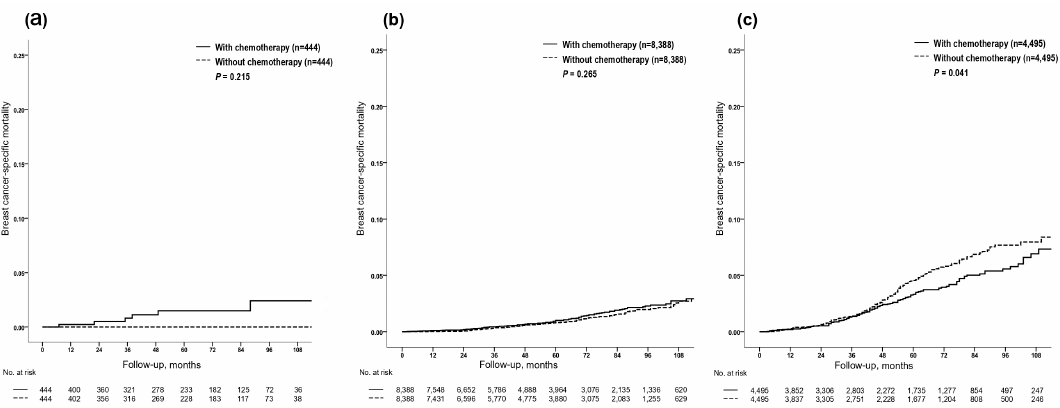
Figure 1. The Kaplan–Meier estimates of the risk of BC death according to chemotherapy by RS risk groups ( < 11, 11–25, > 25) in the matched cohort. ( a ) low-risk, RS < 11; ( b ) intermediate-risk, RS 11–25; ( c ) high risk, RS > 25. Abbreviations: BC, breast cancer; RS, recurrence